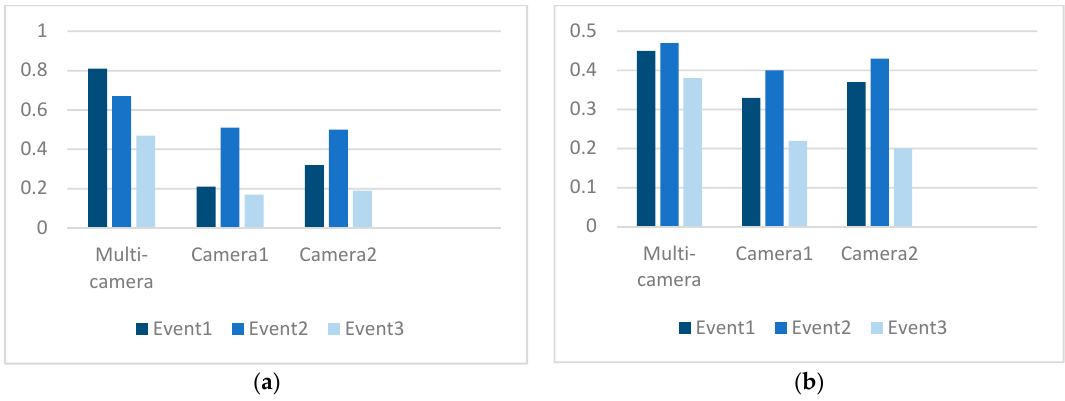
Figure 9. Complex event values: ( a ) Recall; ( b ) precision.